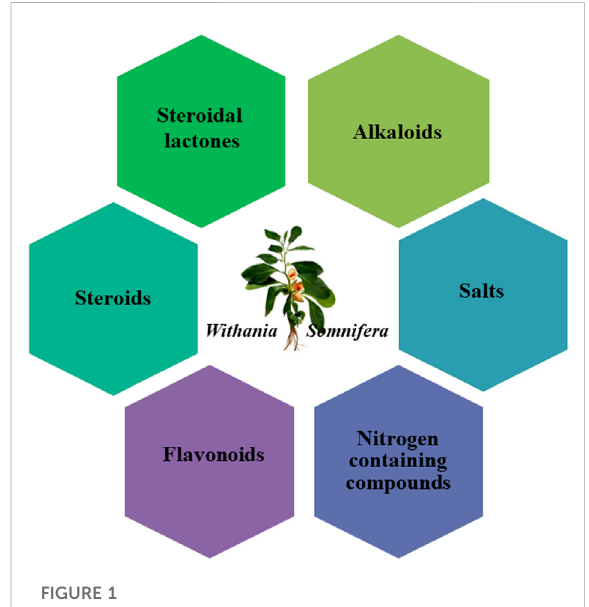
FIGURE 1 Phytochemicals from Withania somnifera